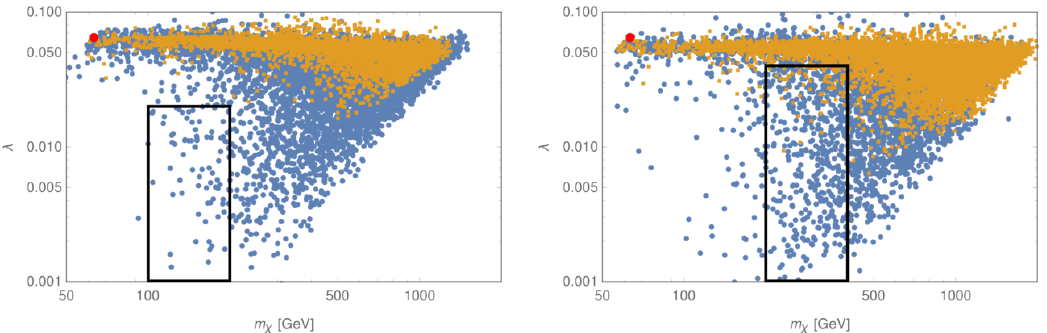
Figure 2 . Distribution in the ( m (cid:31) ; (cid:21) ) plane for the parameter scan of the two-layer model. The left panel corresponds to f = 1 TeV, the right panel to f = 1 : 4 TeV. The black boxes roughly indicate the viable regions of parameters for DM. The red dot shows the approximate prediction of the one-layer model, eq. (3.10). For orange (blue) points, the lightest fermionic resonance is heavier (lighter) than the approximate LHC lower bound of 1